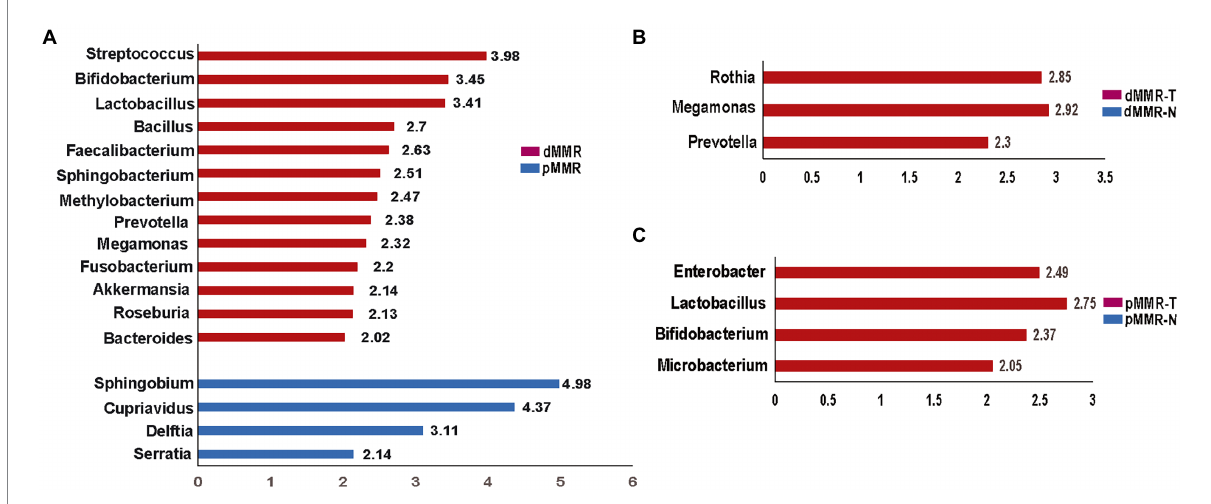
FIGURE 7 Histogram of the LDA scores computed for features by linear discriminant analysis (LDA) effect size (LEfSe) analysis showing bacteria that were altered among the groups. Key taxa with an LDA of >2 are represented between dMMR-T and pMMR-T group (A) , between dMMR-T and dMMR-N group (B) , and between pMMR-T and pMMR-N group (C) . dMMR-T, dMMR tumor tissue samples (red); dMMR, deficient DNA mismatch repair; pMMR, proficient DNA mismatch repair; pMMR-T, pMMR tumor tissue samples (blue); dMMR-T, dMMR normal paracancerous samples (red); pMMR-T, pMMR normal paracancerous samples